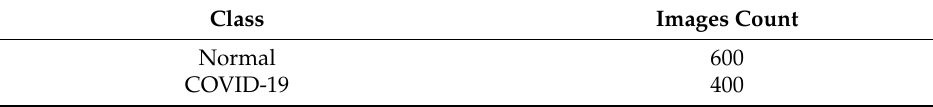
Table 4. Dataset summary of classification for